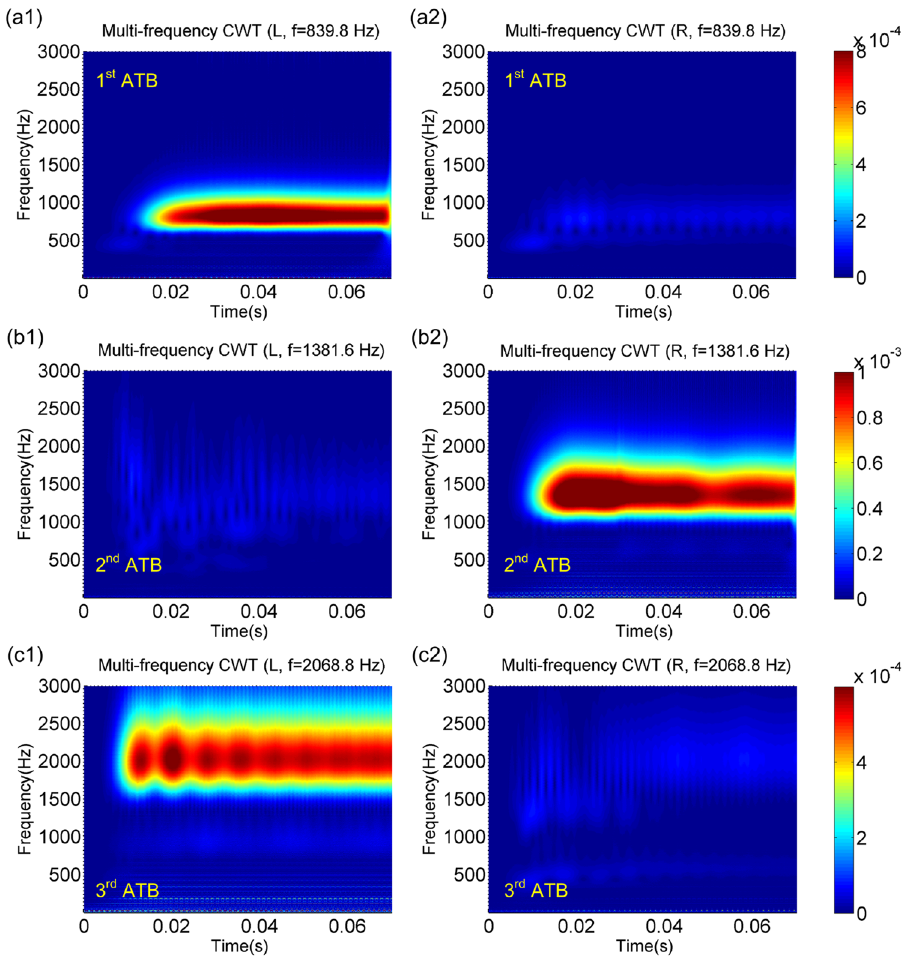
Figure 5. Multi-frequency CWT results of the displacements obtained at the 6 th unit cell far from different input ends under the peak excitation frequencies in the ( a ) 1 st , ( b ) 2 nd and ( c ) 3 rd